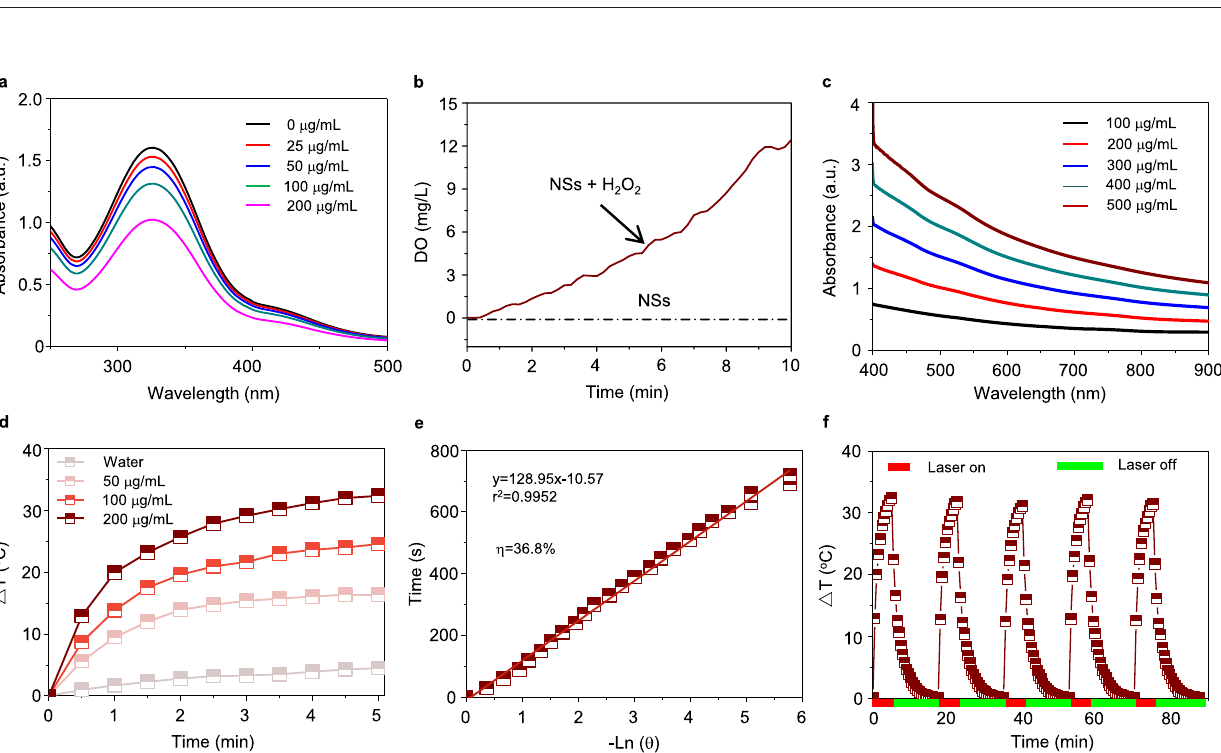
Fig. 3 TME modulation and photothermal conversion performance of FCL-PEG NSs. a GSH degradation pro fi le treated with FCL-PEG NSs at different concentrations. b O 2 production in H 2 O 2 solution treated with FCL-PEG NSs. c The light absorbance spectra of FCL-PEG NSs. d The photothermal conversion performance of FCL-PEG NSs (0 – 200 μ g/mL) irradiated by an 808 nm laser (2 W/cm 2 ). e The linear relationship between − ln θ and time. f Heating and cooling curves of the FCL-PEG NSs. GSH